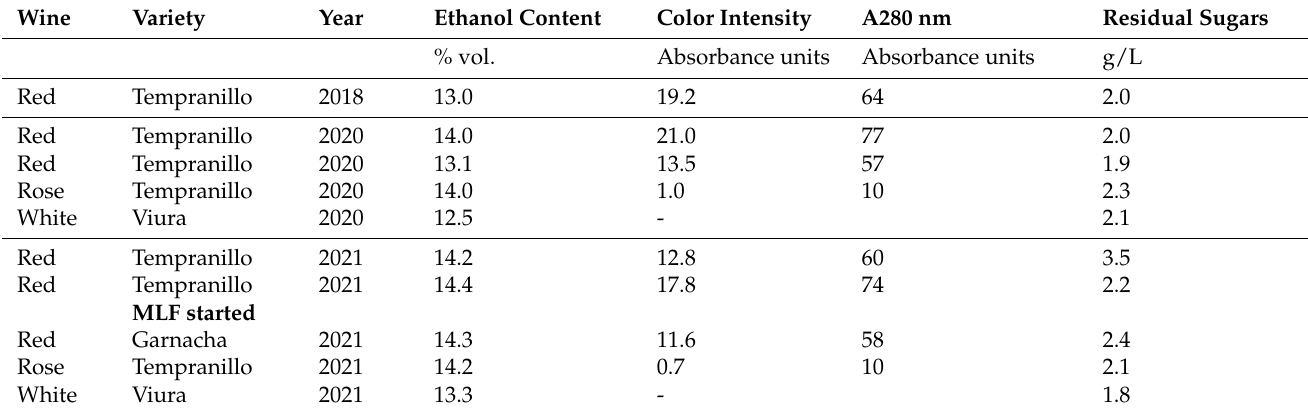
Table 1. Main enological parameters of the wines used for the inhibition trial with fumaric acid.